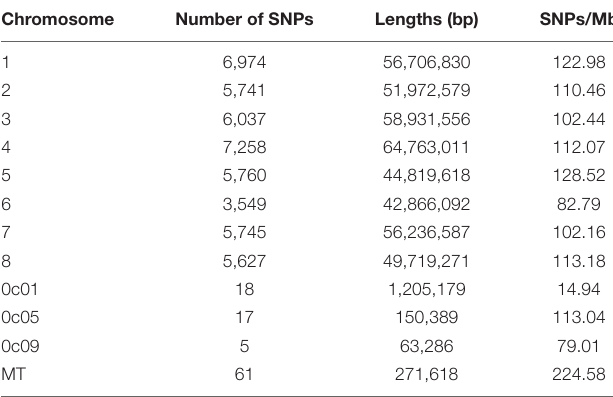
TABLE 1 | SNP distribution and frequency across the genome of M. truncatula